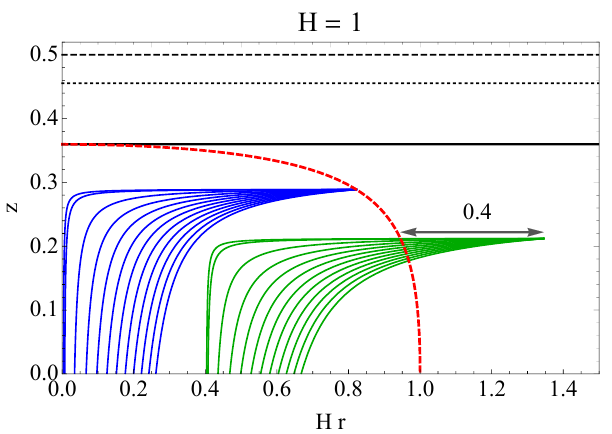
Figure 11 . Blue and green curves are two families of null geodesics, originating on a generic point of the extremal surface with z ∗ = z EH and a generic point in the bulk that is not enclosed by the extremal surface. The fact that this family just reaches the observer at the origin implies that the extremal surface is the (bulk) cosmological horizon of an observer at the origin ( r = 0 ).